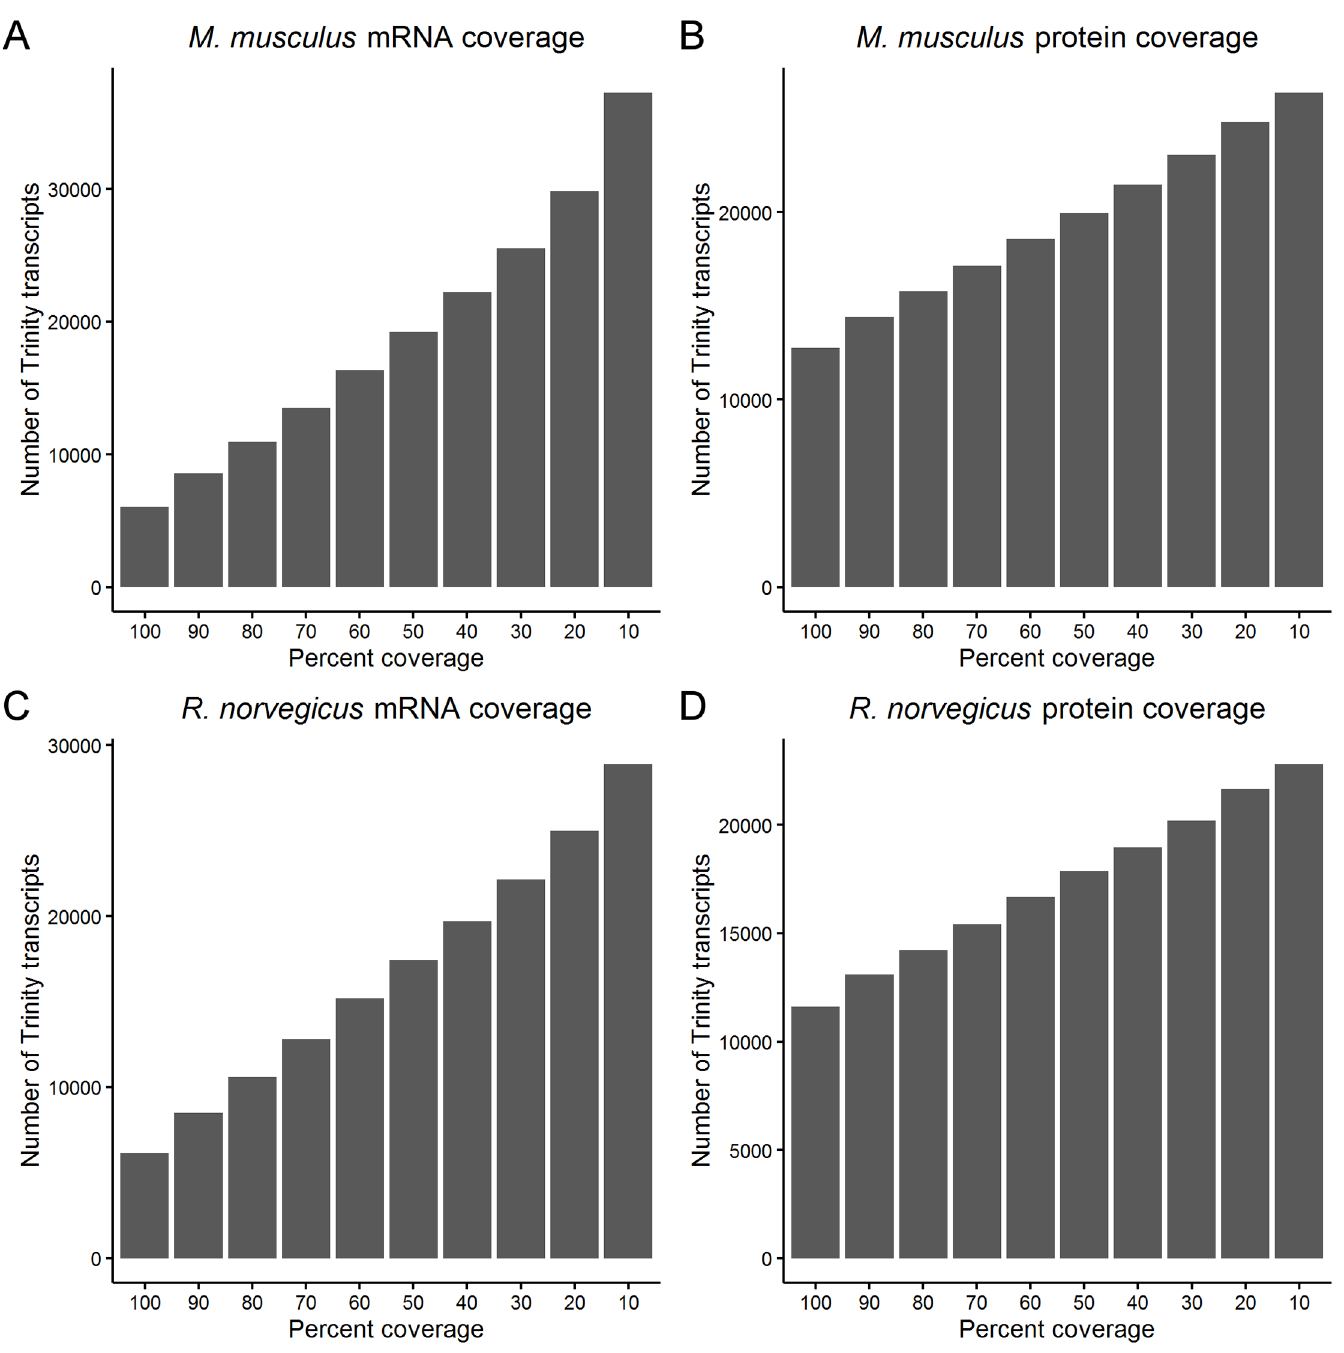
Fig 3. Coverage of M . musculus and R . norvegicus mRNA transcripts and proteins. The coverageof M . musculus A) mRNA and B) protein and R . norvegicus C) mRNA and D) proteinprovidedby transcripts from the de novo assembled A . ansorgei transcriptome. For a Trinity transcript in bin of percent coverage n , the Trinity transcript covers at least n -10%of the length of the target mRNA or